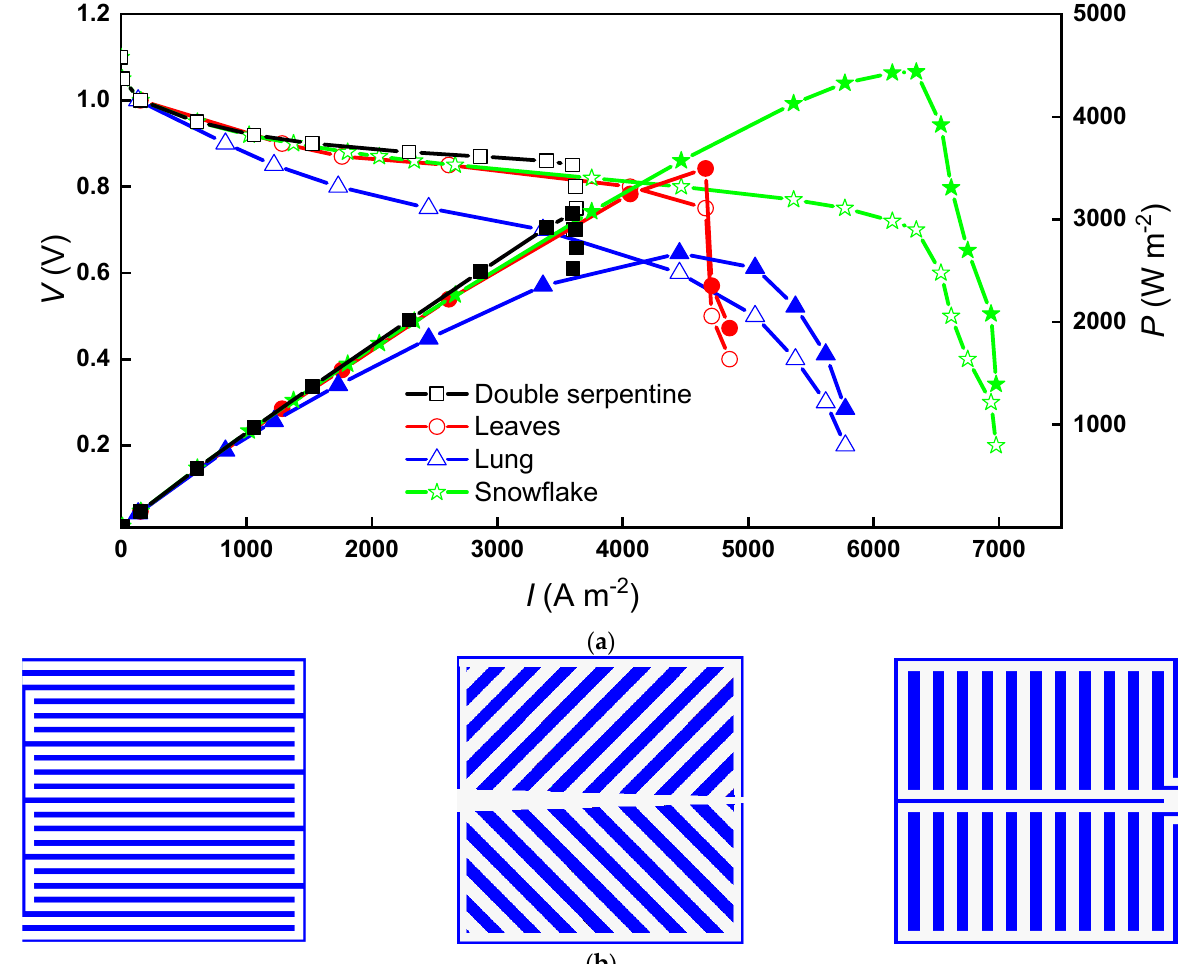
Figure 3. The polarization curve and power density curve of PEM fuel cells with various designs: ( a ) U - I curve; ( b ) dual serpentine, leaf, and lung designs.